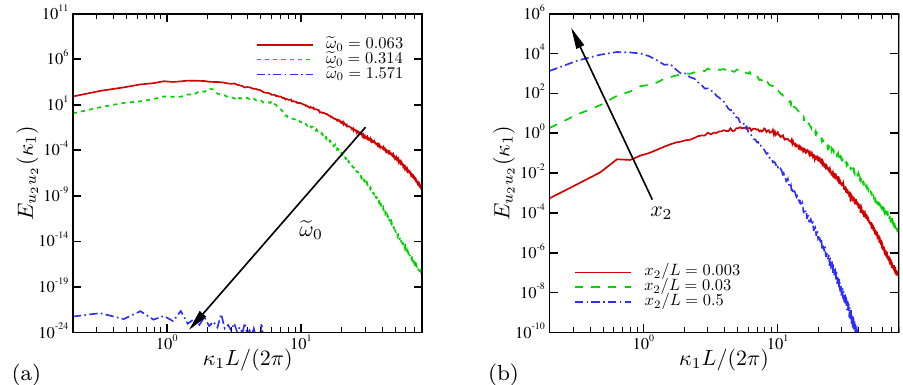
Figure 10. Spatial power spectral density of wall-normal velocity at ( a ) x 2 / L = 0.1 for three oscillation frequencies and ( b ) several positions from the electrode surface for